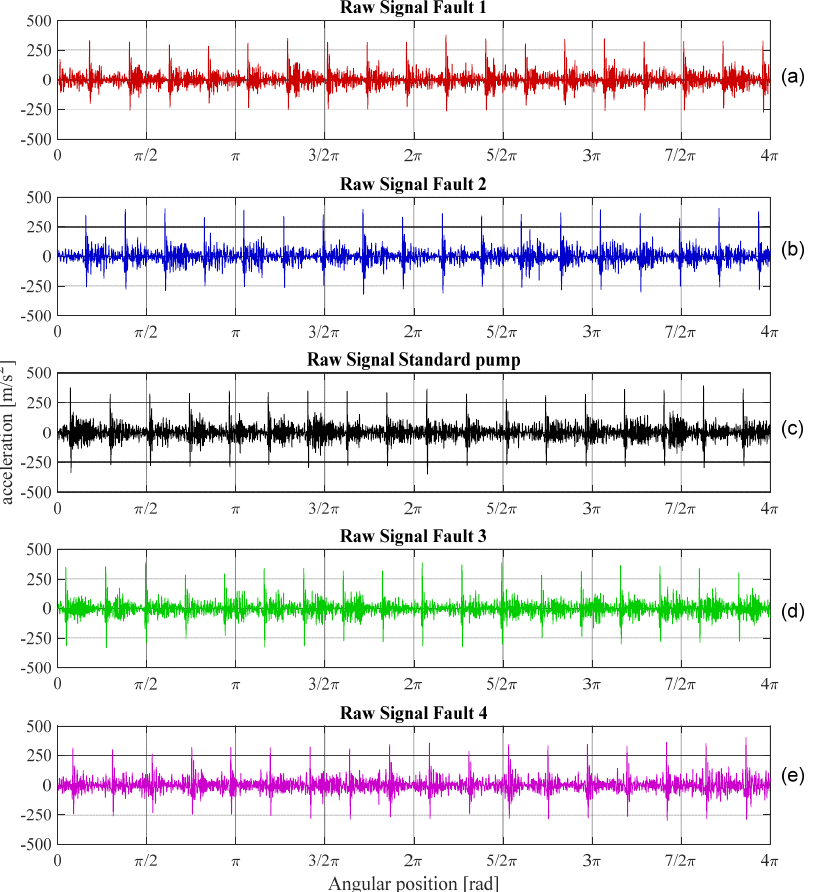
Figure 3. Raw signal for fault 1 ( a ), fault 2 ( b ), the flawless pump ( c ), fault 3 ( d ), and fault 4 ( e ) for the signal acquired with sensor 1 (1500 r/min, 150 bar).